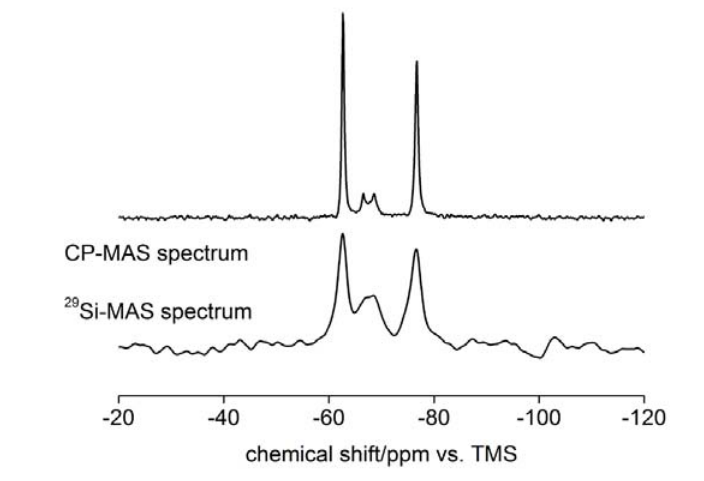
Figure 2 . 29 Si-MAS and 1 H- 29 Si CP MAS SSNMR spectrum of an as-prepared